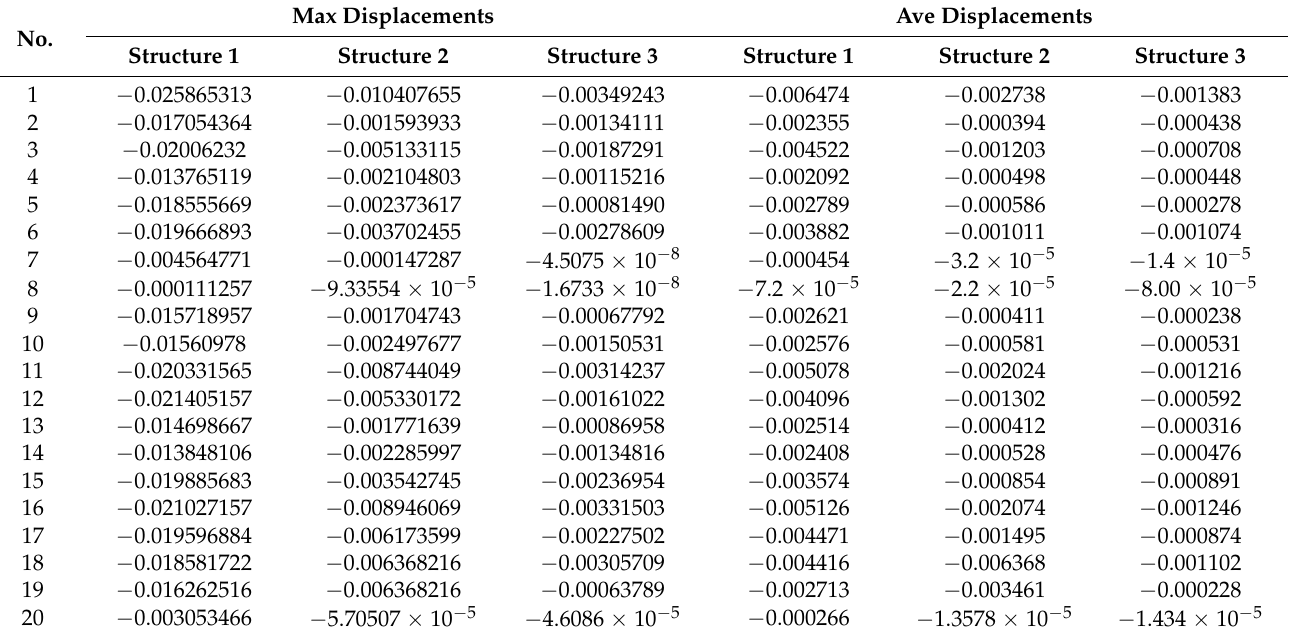
Table 7. Displacements of all points collected from the bottom of